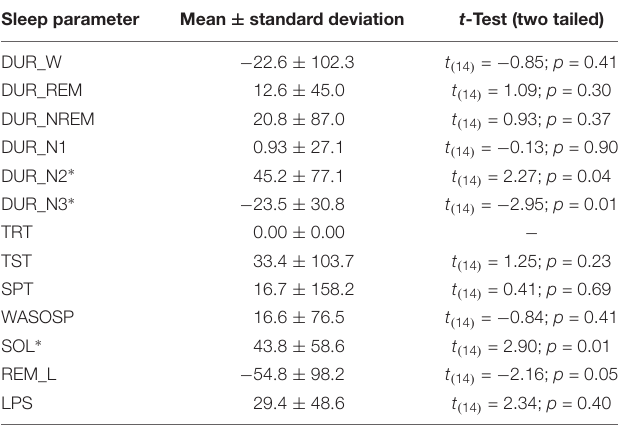
TABLE 4 | Pearson correlations between SomnoHD and cEEGrid for sleep parameters obtained from scorer 1.